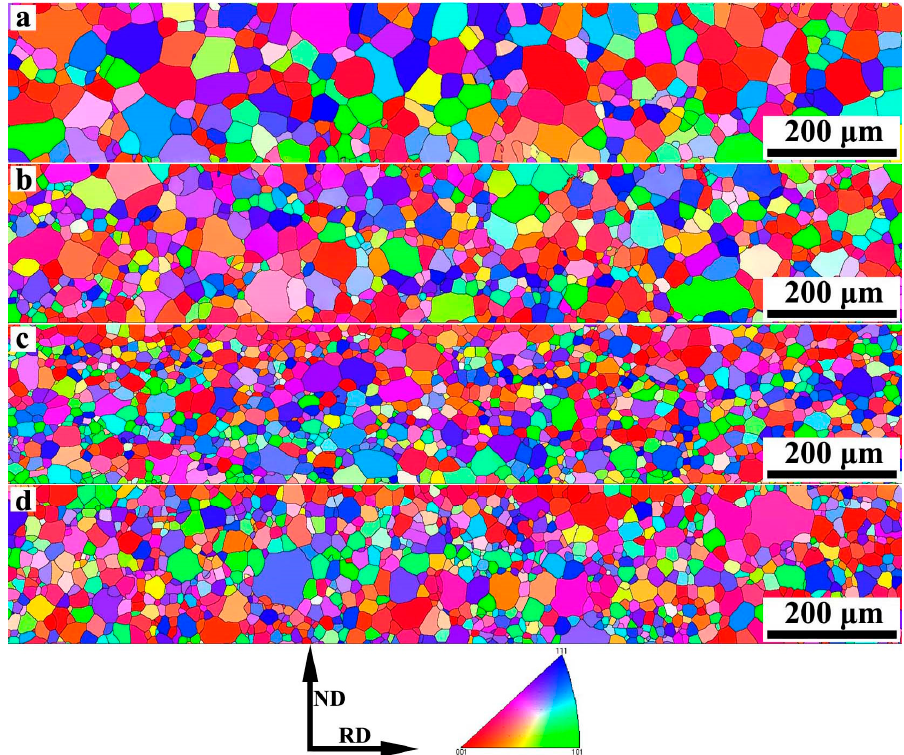
Figure 4. Inverse pole figure (IPF) of primary recrystallized sheets with different Nb content ( a ) Nb-free, ( b ) Nb-0.005 wt%, ( c ) Nb-0.009 wt%, ( d ) Nb-0.025 wt%.